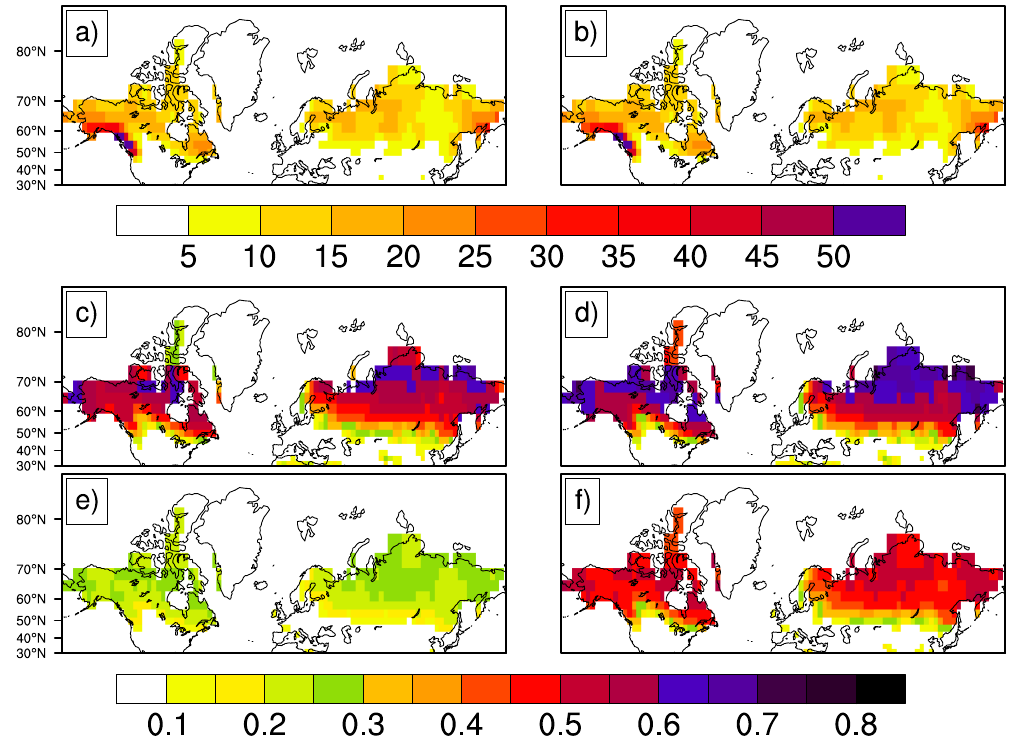
Fig. 1. This figure shows the snow-masking performance of MPI-ESM based on the pre-industrial simulations 0k(AV) w and 0k(AV) s with weak and strong snow masking, respectively. The upper two panels show the snow water equivalent in cm for March for both parameteri- sations with weak snow masking (a) and with strong snow masking (b) . The panels below show the difference between the albedo of grass (VIS+NIR) and the albedo of forest (VIS+NIR) for March. We refer to this difference as strength of snow-masking ( δ α ). The left column shows δ α for the parameterisation with weak snow masking separately for evergreen forest (c) and for deciduous forest (e) . The right column shows δ α for the parameterisation with strong snow masking separately for evergreen forest (d) and for deciduous forest (f)